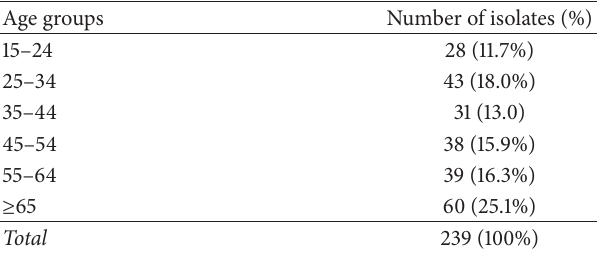
Table 6: Results of multivariate analysis of predictors of